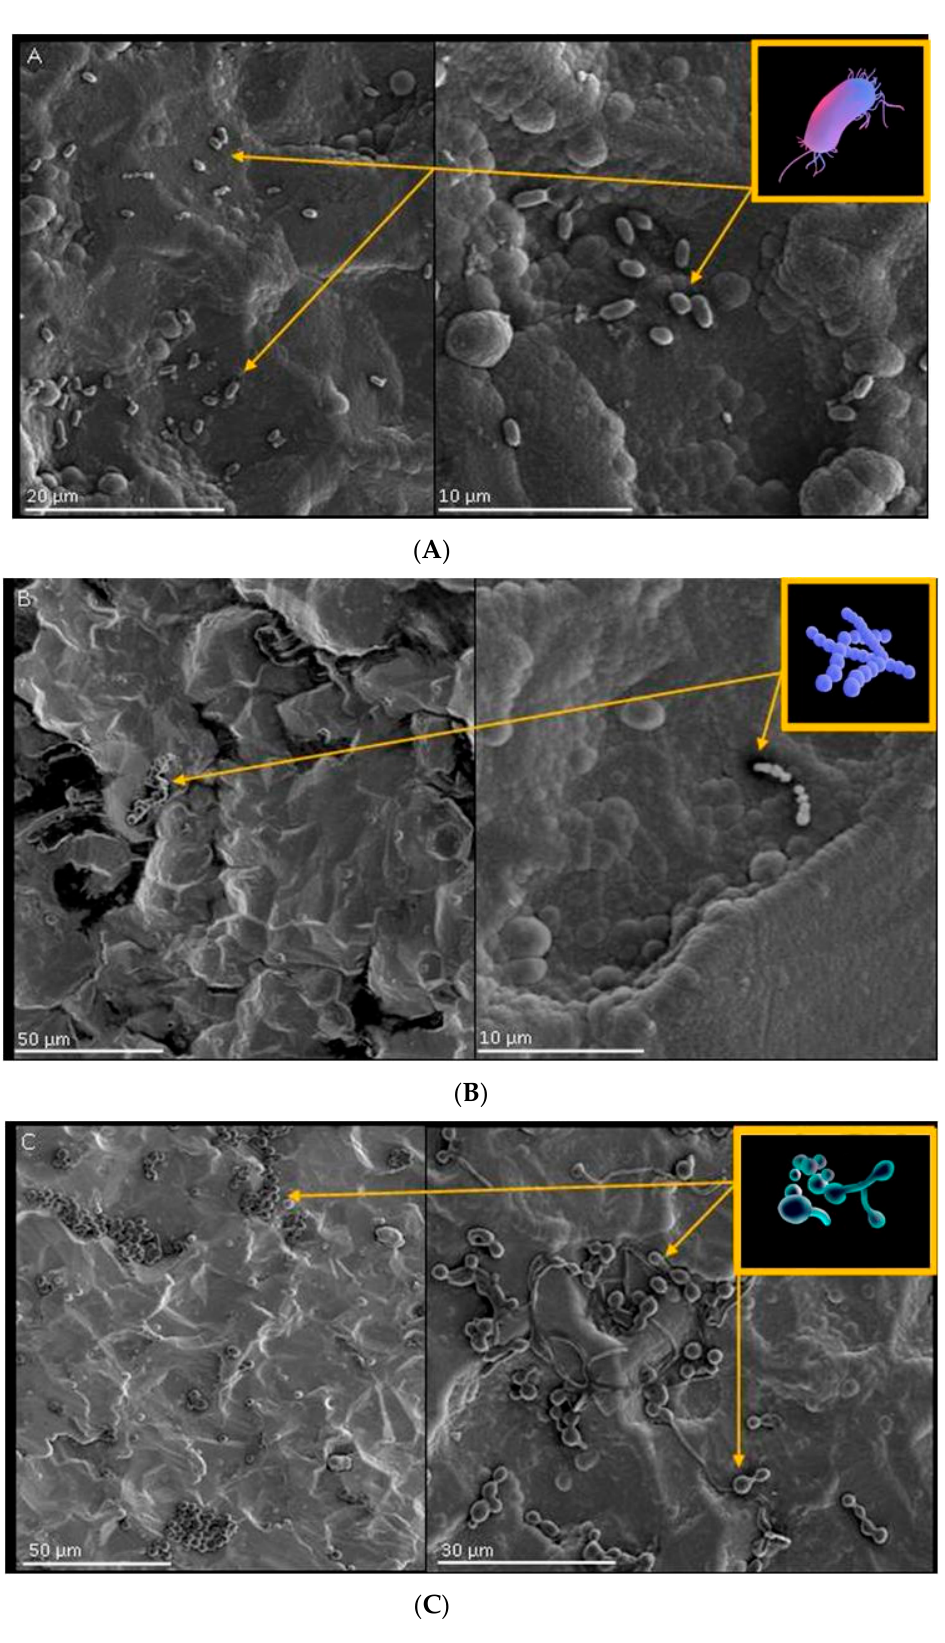
Figure 5. Colonization of the tested biomaterial (Ti/TiN + 7.5% Ag) by microorganisms (bacteria and fungi). Surface morphology (SEM) with the: ( A ) Pseudomonas aeruginosa , ( B ) Streptococcus pyogenes , ( C ) Candida albicans .